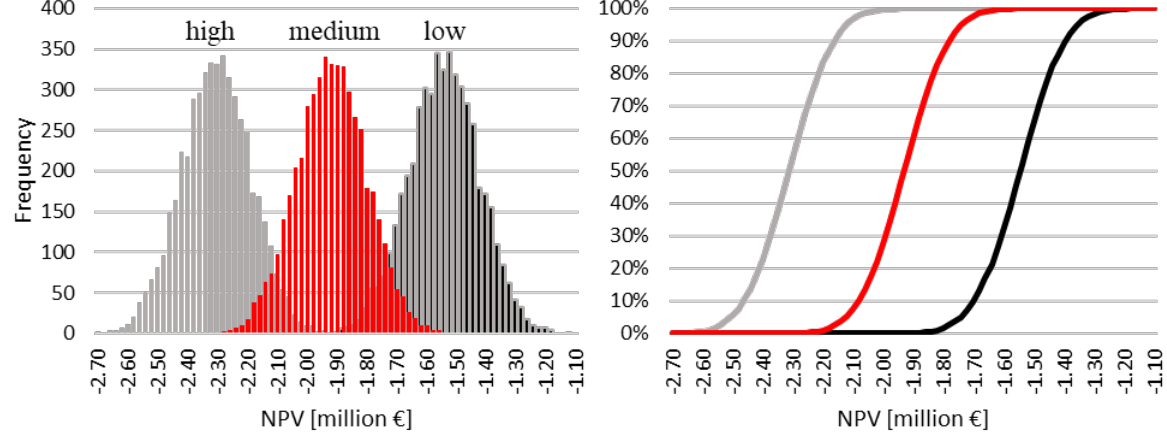
Figure 8. Probabilistic NPV for LCC calculation models incorporating three distinct unit costs for district heating.